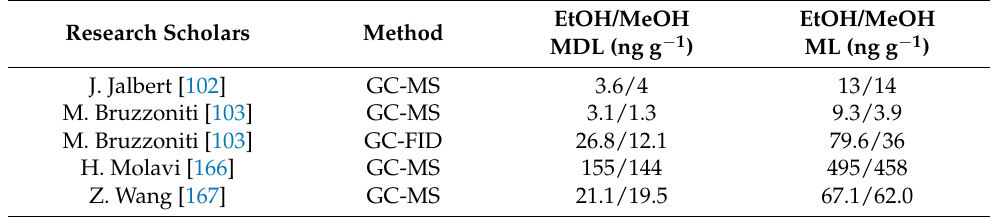
Table 3. Detection limits and quantification limits of ethanol/methanol under different